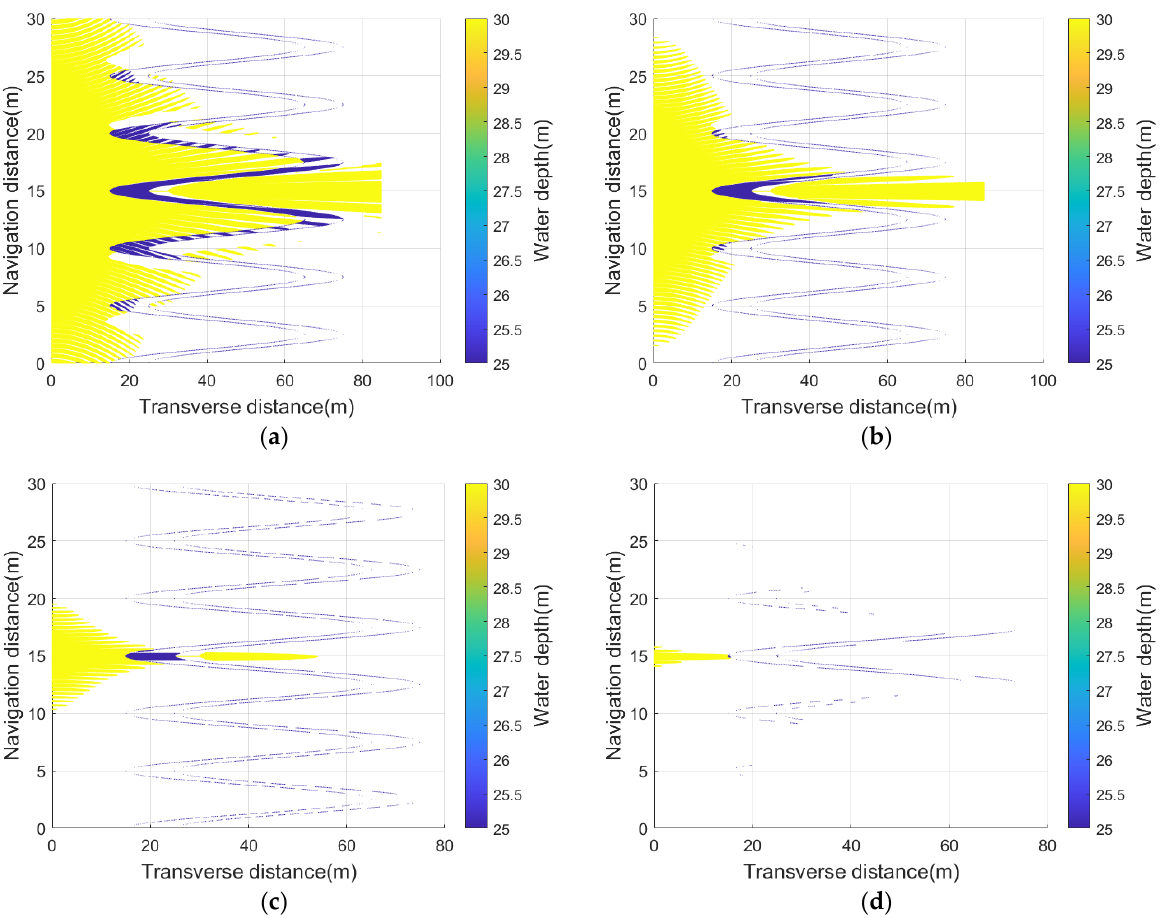
Figure 15. Scanning seabed samples processed under different simplification scales using a receiv- ing sensor as center frequency 400 kHz, horizontal beam width 0.56 ◦ : ( a ) is simplified to 5125 data points; ( b ) is simplified to 3000 data points; ( c ) is simplified to 1000 data points; ( d ) is simplified to 176 data points.